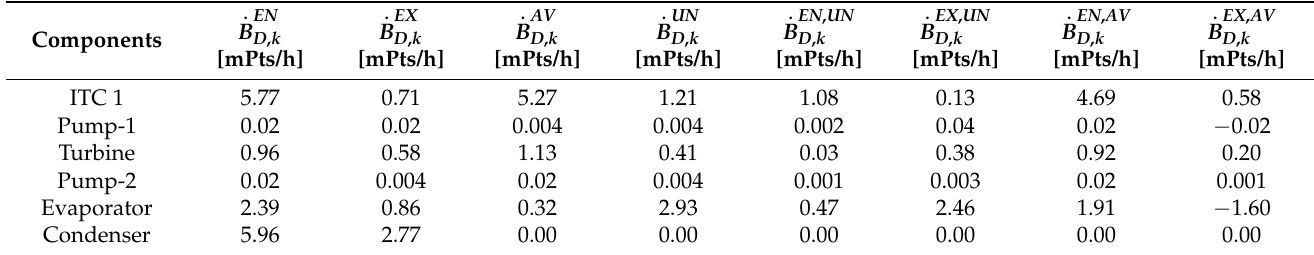
Table 15. Associated environmental impact by exergy on each component.